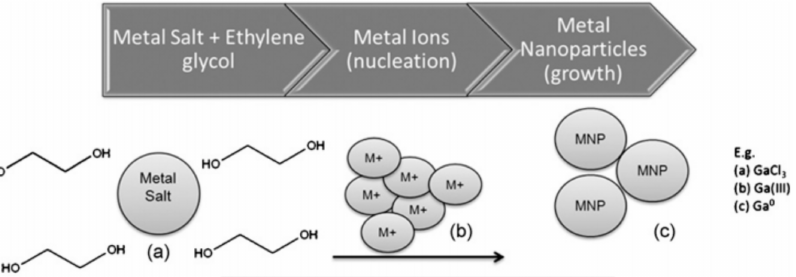
Figure 9. Schematic representation of the method employed by Regan’s team. Adapted from